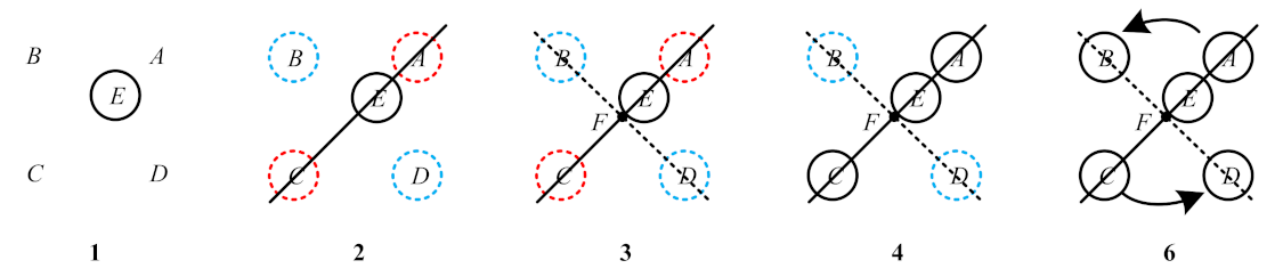
Figure 5. Steps 1, 2, 3, 4, and 6 decode the schematic